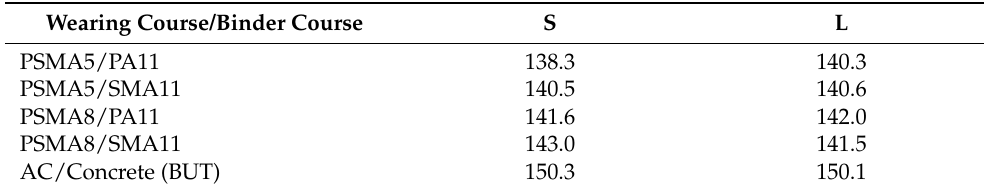
Table 12. The averaged dynamic stiffness from all measurements in situ (S) and laboratory measure- ments (L), dB re. 1